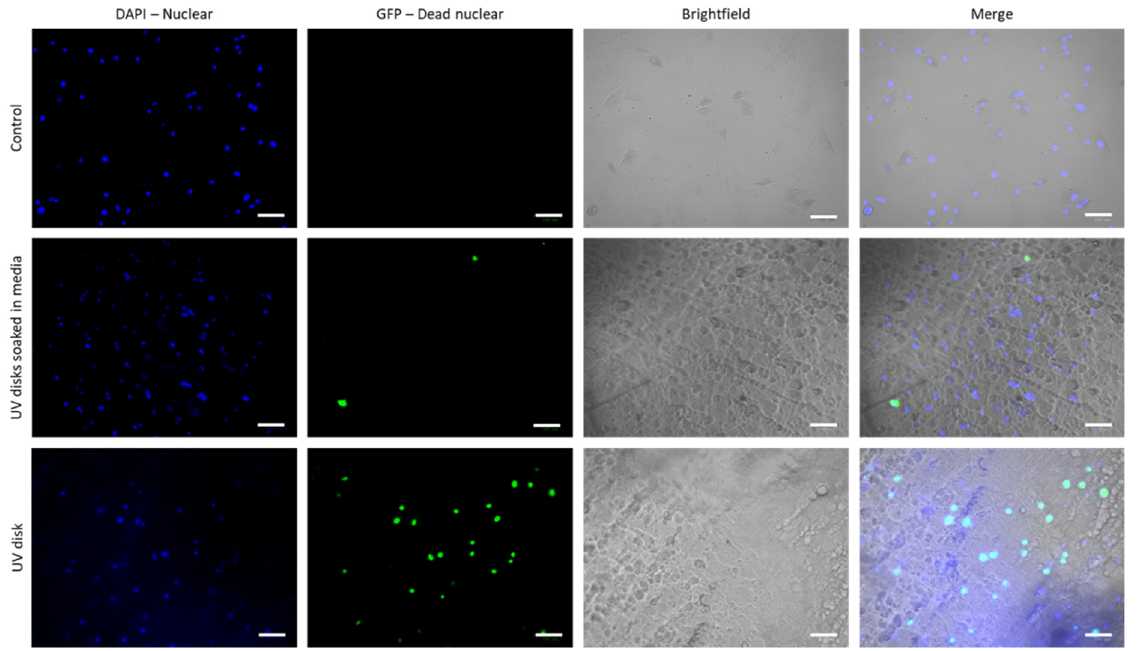
Figure 10. Cell imaging with blue and green staining. Human dermal fibroblasts in the concentration of 1 × 10 5 cells per well were seeded on 96-well plates without disks (control), UV-sterilized and media-soaked disks for 2 h and 48 h, respectively, and 2 h UV-sterilized disks only. Staining was